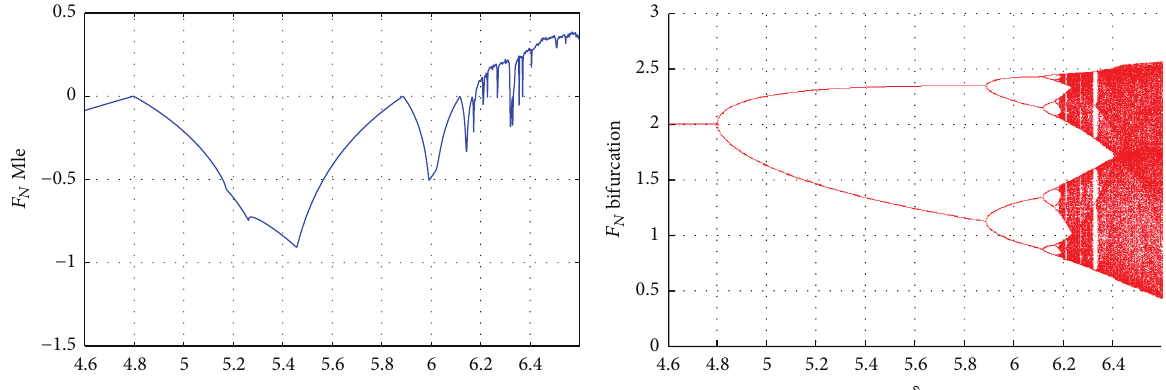
Figure 1: Largest Lyapunov exponents and bifurcation diagram of system (25) for 𝑎 = 0.8 , 𝑏 = 0.8 , 𝑐 = 0.4 , 𝑑 = 0.2 , 𝑘 = 5 , 𝑙 = 2 , and = 0.18 with the initial value of (𝑥,𝑦) = (1,1) and 𝛿 covering [4.6, 6.6] . 𝐴 1